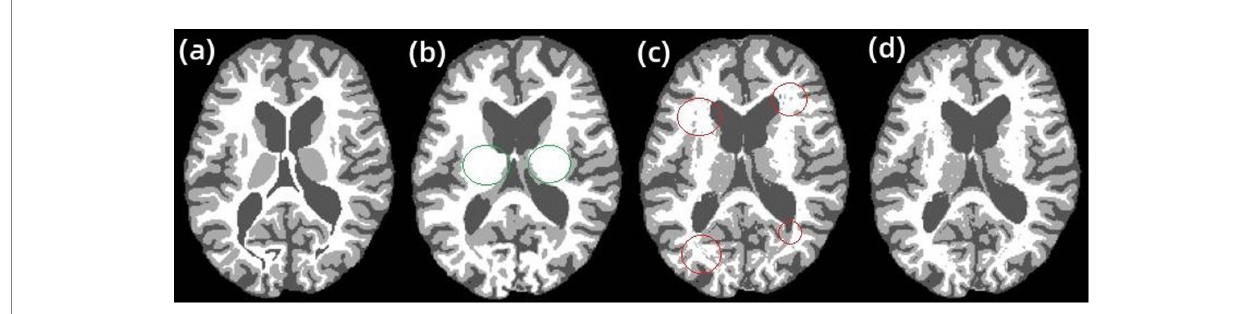
FIGURE 8 RFCM, AR-FCM, and LFA-FCM segmentation results. (A) gt, (B) RFCM, (C) AR-FCM, and (D) LFA-FCM.